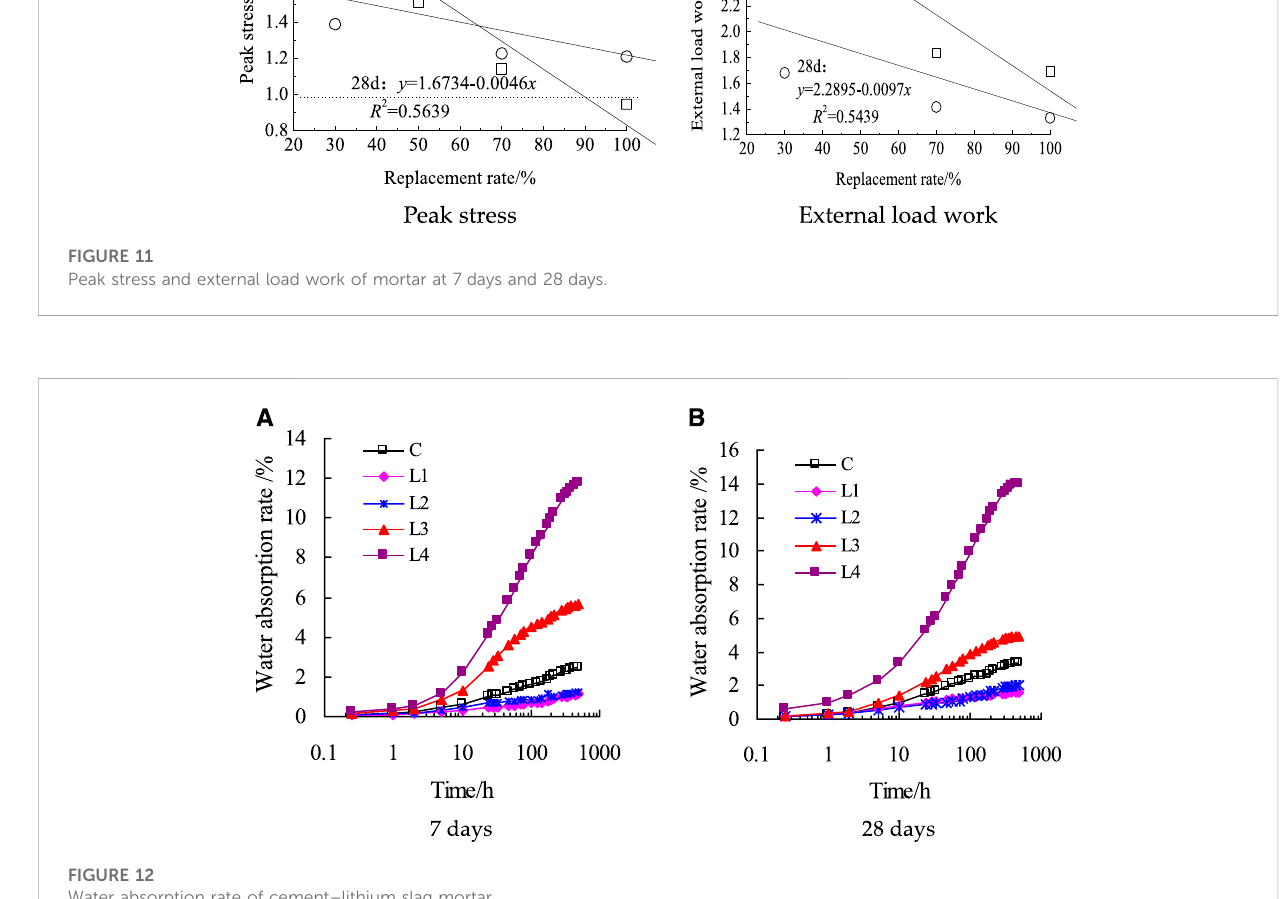
FIGURE 12 Water absorption rate of cement – lithium slag